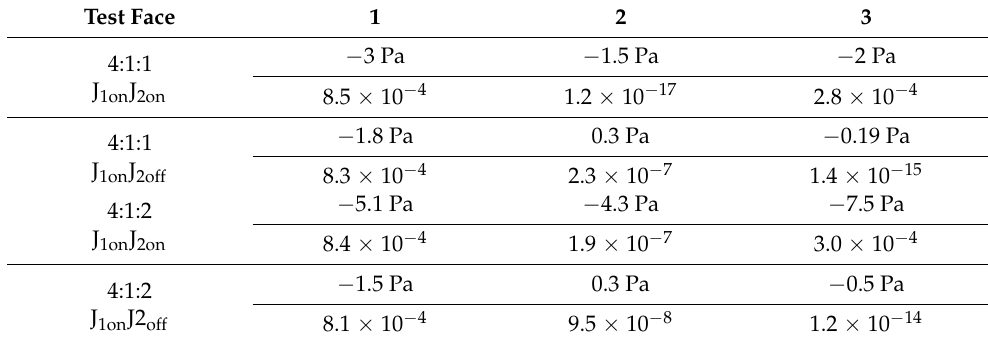
Table 14. Detection surface pressure and concentration